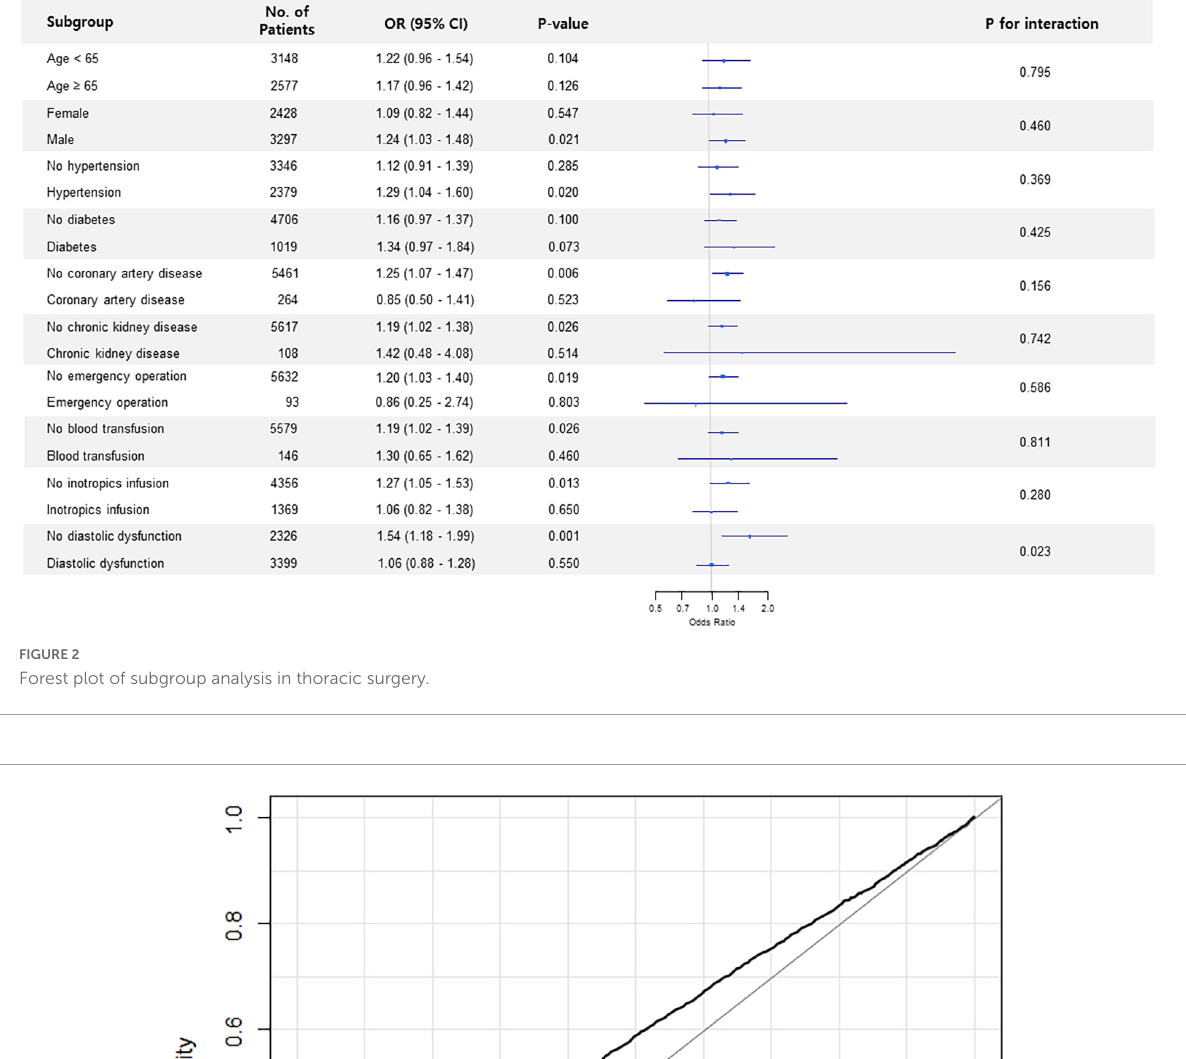
Frontiers in Cardiovascular